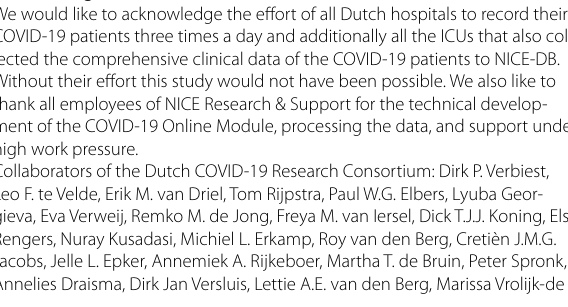
waves. Table S1. Patient characteristics. Table S2. Crude and adjusted logistic regression showing Odds ratios of hospital death during Wave 2, Wave 3, and the period in‑between compared to Wave 1 (see Fig. 2). Table S3. Crude and adjusted Cox regression showing higher Hazard ratios of ICU discharge during Wave 2, Wave 3, and the period in‑between compared to Wave 1 (see Fig. 3). A Hazard ratio of ICU discharge higher than 1.00 implies a comparatively high rate of discharge and, thus, a shorter length of stay at the ICU. Shown are an analysis with death as ICU discharge event and an analysis with death as censoring